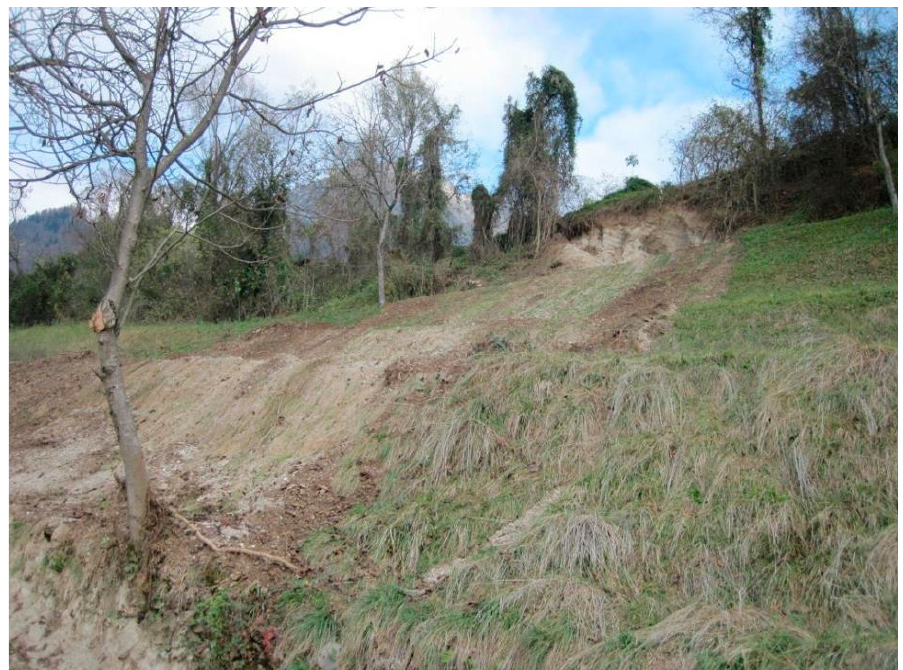
Figure 4. Landslide photograph code 025021_02c.